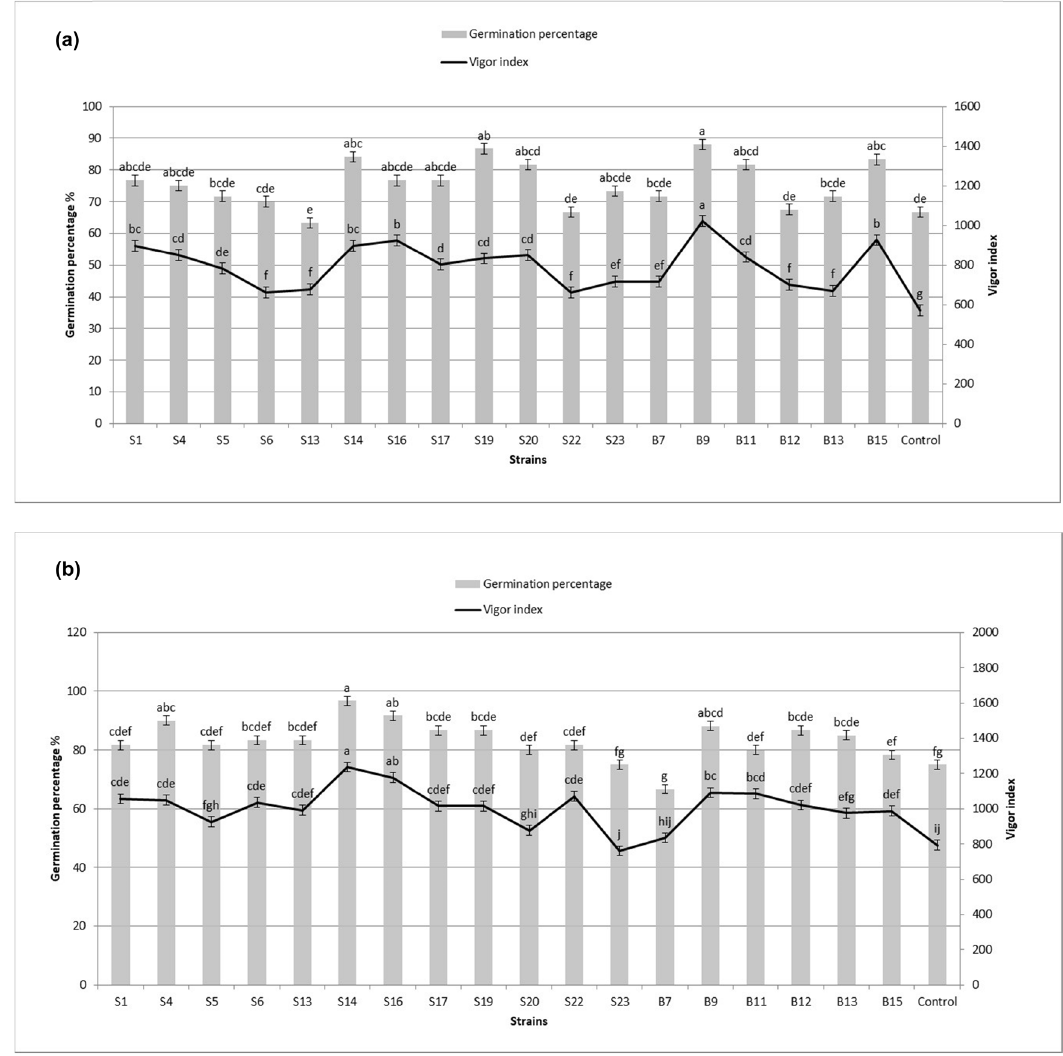
Figure 3: Germination percentage and vigor index of bacterial treatments according to varieties ( a ) Foolewouh and ( b )